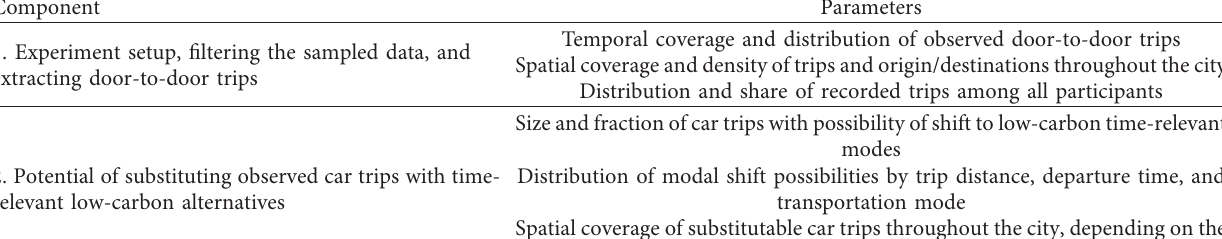
Table 1: Components of the computational framework together with parameters evaluated in experimental results.